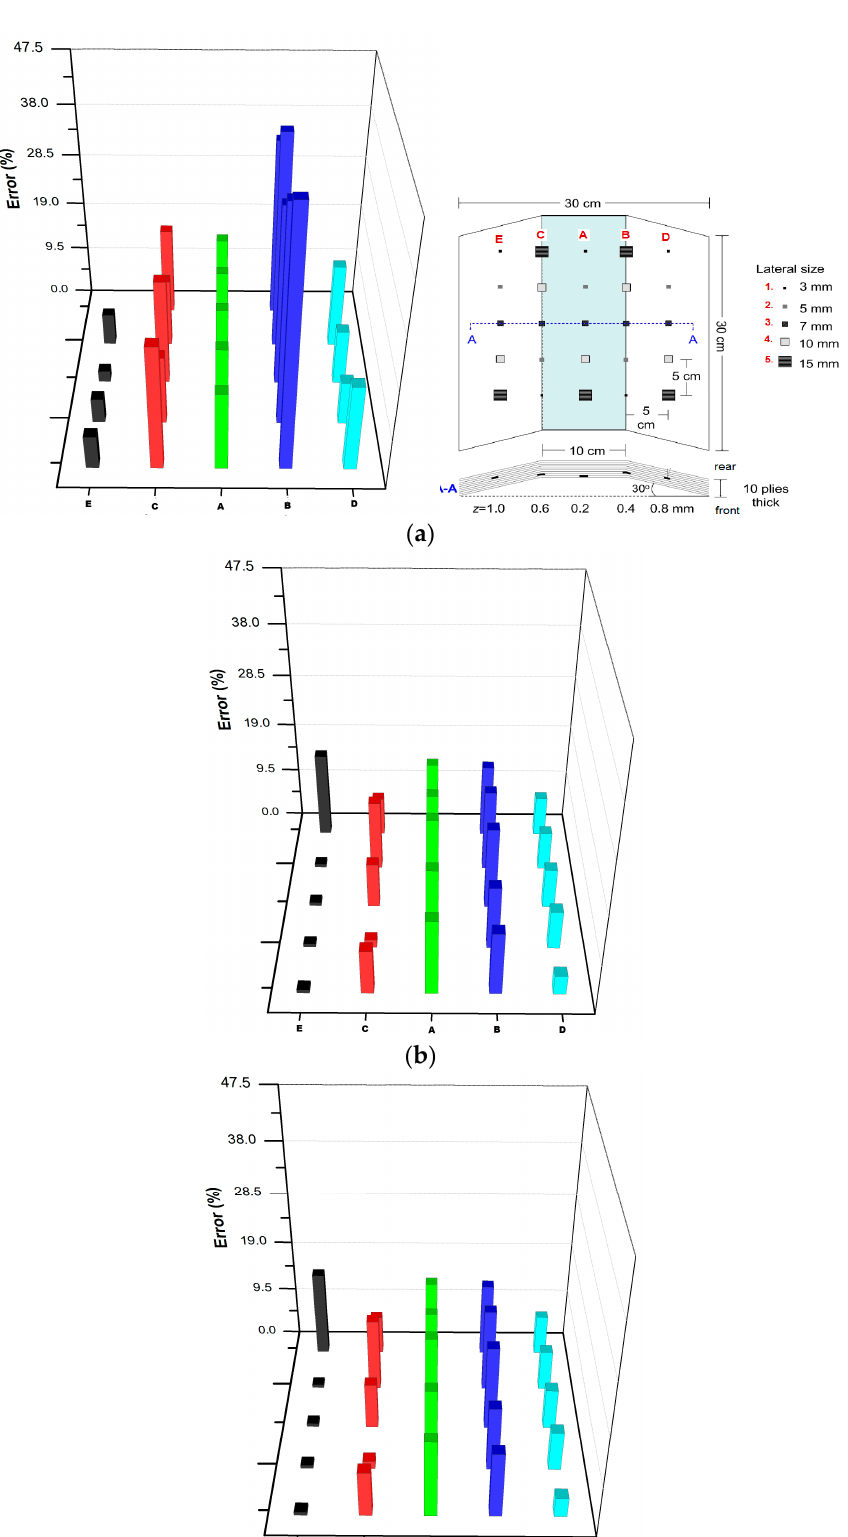
Figure 12. 3D representation of insertions estimated depth in terms of error production for all the detected defects in the trapezoid specimen through: ( a ) peak slope time; ( b ) blind frequency (random sound area); and ( c ) blind frequency (overall surface) .